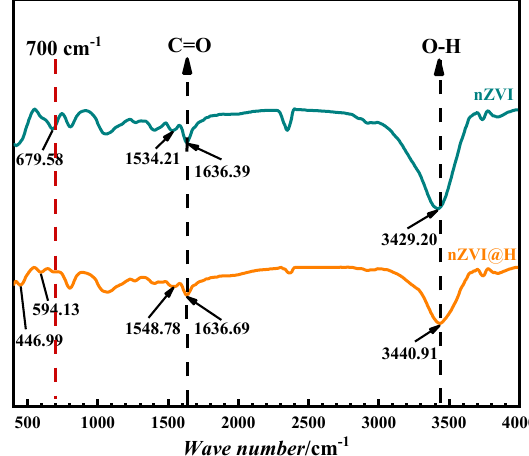
Figure 4. FTIR images of nZVI and nZVI@H.